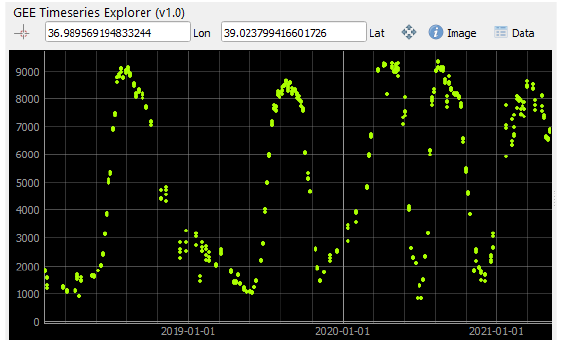
Figure 2 . Exemplary NDVI time series (2018-2021) on Sentinel-2AB surface reflectance product.